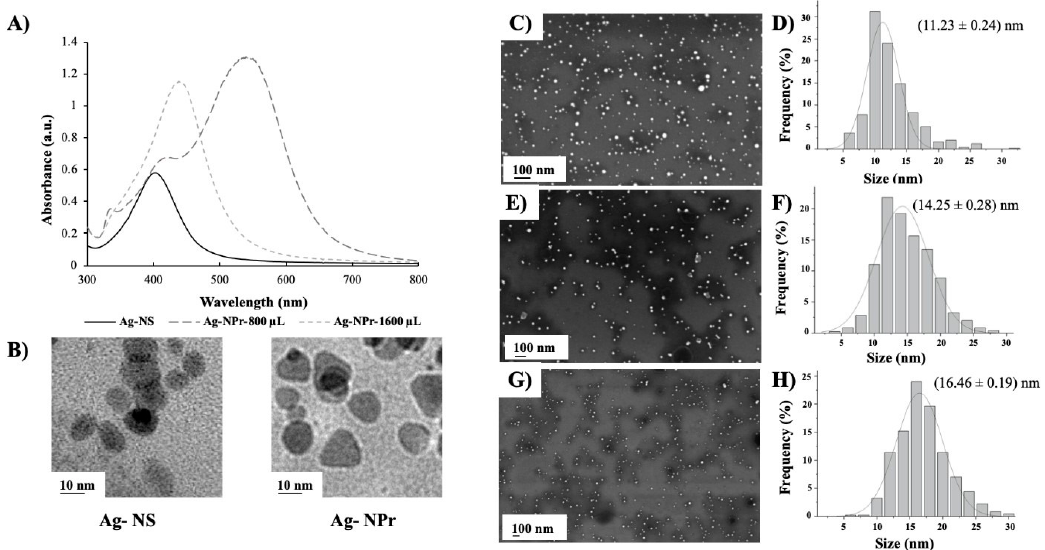
Figure 1. ( A ) UV–VIS spectra of Ag-NS, Ag-NPr (800 µ L), and Ag-NPr (1600 µ L); ( B ) TEM micrographs for Ag-NS and Ag-NPr (800 µ L). SEM characterization and corresponding size distribution histograms for the Ag-NS ( C , D ) and Ag-NPr obtained using 800 µ L ( E , F ) and 1600 µ L ( G , H ) of Ag-NS as a precursor.